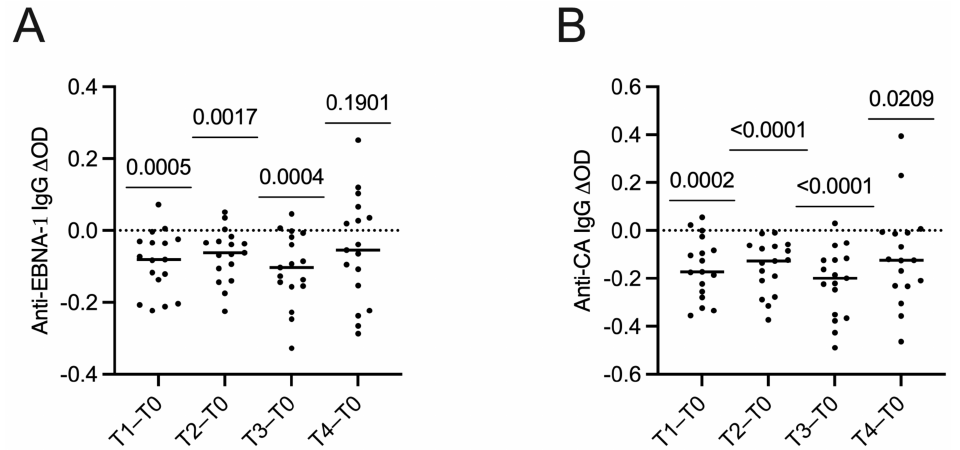
Figure 1. Changes in serum levels of anti-Epstein–Barr virus nuclear antigen-1 (EBNA-1) ( A ) and anti-capsid antigen (CA) ( B ) IgG expressed as delta ( ∆ ) optical density (OD) values in 17 relapsing– remitting multiple sclerosis patients during dimethyl fumarate treatment. Time points refer to pre-treatment (T0) and after 7 days (T1) and 1 (T2), 3 (T3) and 6 (T4) months of therapy. For each patient, the OD value of the first sample taken at T0 was subtracted from the further time points, calculating ∆ OD values (T1 − T0, T2 − T0, T3 − T0 and T4 − T0). The ∆ OD values were compared at all time points with the Wilcoxon Signed Rank Test.